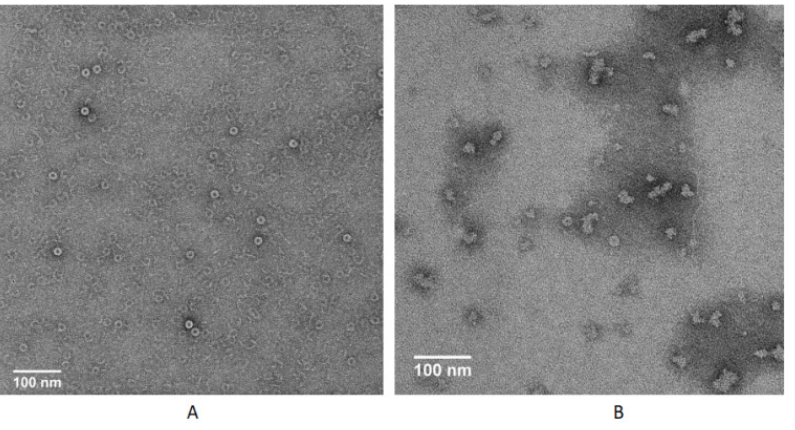
Figure 3. 20S CP disk assembly inhibition of compound 14b (100 nm scale bar): ( A ) CP, ( B ) CP + 10 µM 14b .